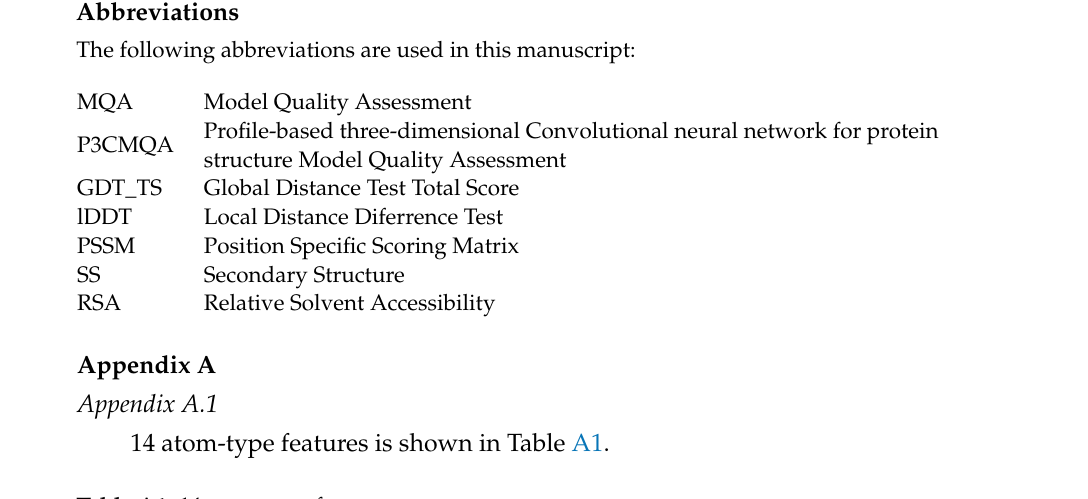
Table A1. 14 atom-type